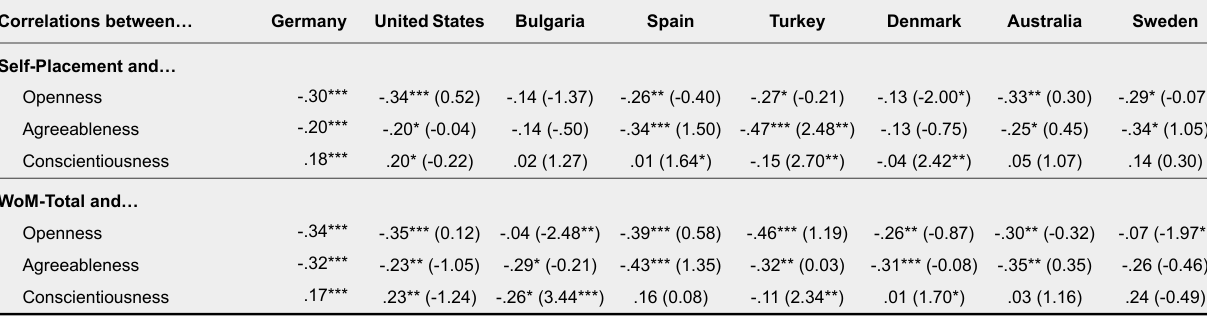
Correlations Between Personality and Political Outcomes in All Samples SwedenAustraliaDenmarkTurkeySpainBulgariaUnitedStatesGermanyCorrelations between… Self-Placement and…